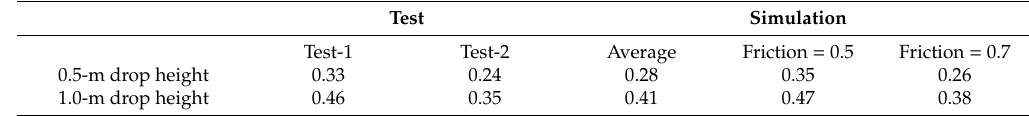
Table 2. Comparison between penetration